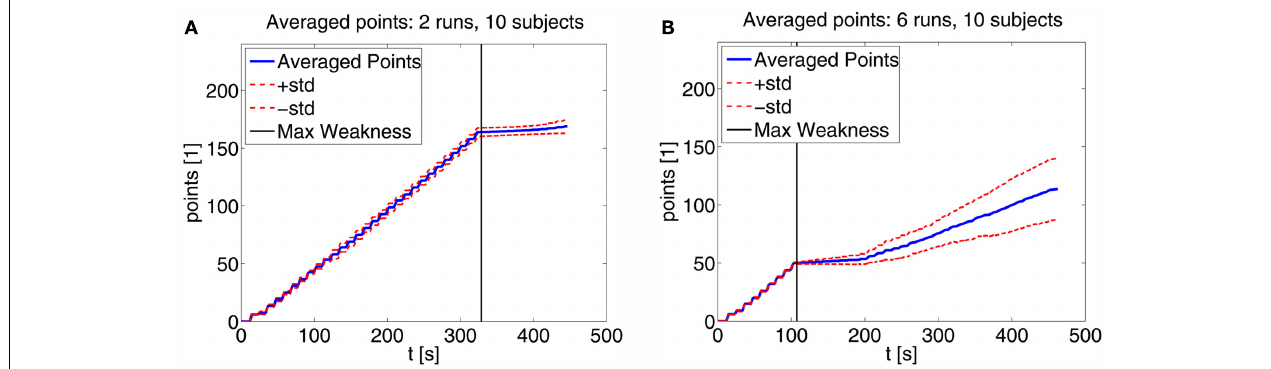
The first points were always collected with the joystick which was weakened within the first 10 trials up to a point when no more collection was possible. After this stagnation, the monitoring system initiated the first switch to BCI and would continue to monitor both input qualities and decide which control method was best at the